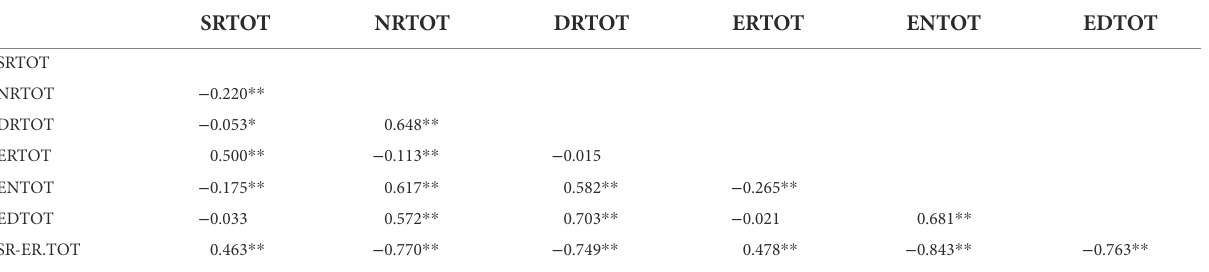
TABLE 5 Correlation between internal and external regulation and the total score for the scale ( n =